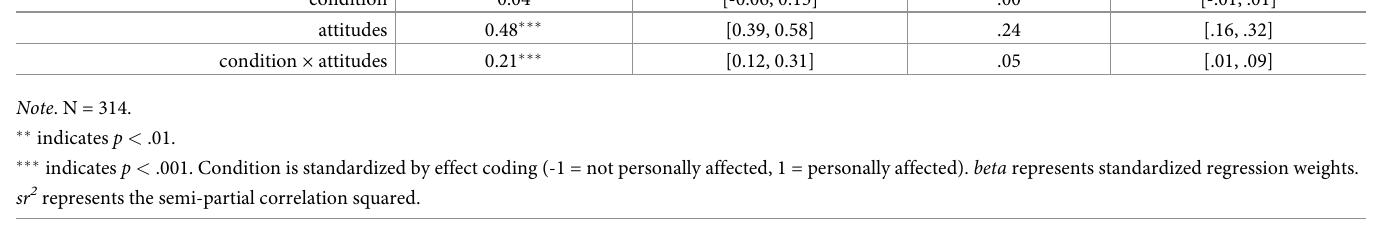
Note . N = 314. �� indicates p < .01. ��� indicates p < .001. Condition is standardized by effect coding (-1 = not personally affected, 1 = personally affected). beta represents standardized regression weights. sr 2 represents the semi-partial correlation squared.